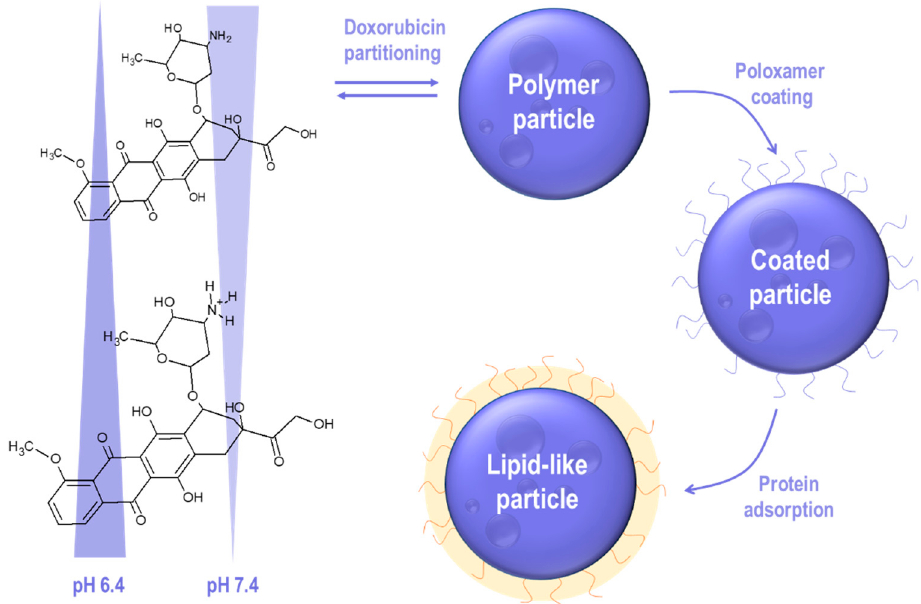
Figure 1. Illustration of the synthesis and adsorption process involved in drug delivery using lipid-like polylactide-co-glycolide (PLGA) nanoparticles loaded with doxorubicin.